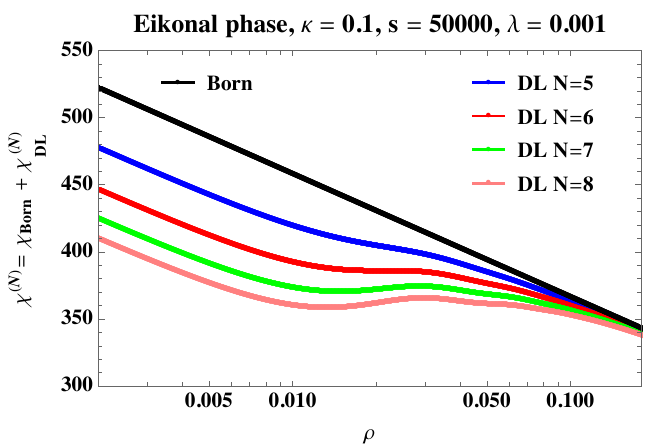
Figure 10 . The Born eikonal phase and its value plus the DL corrections for a (cid:12)xed energy s = 50000 and di(cid:11)erent supergravity theories.